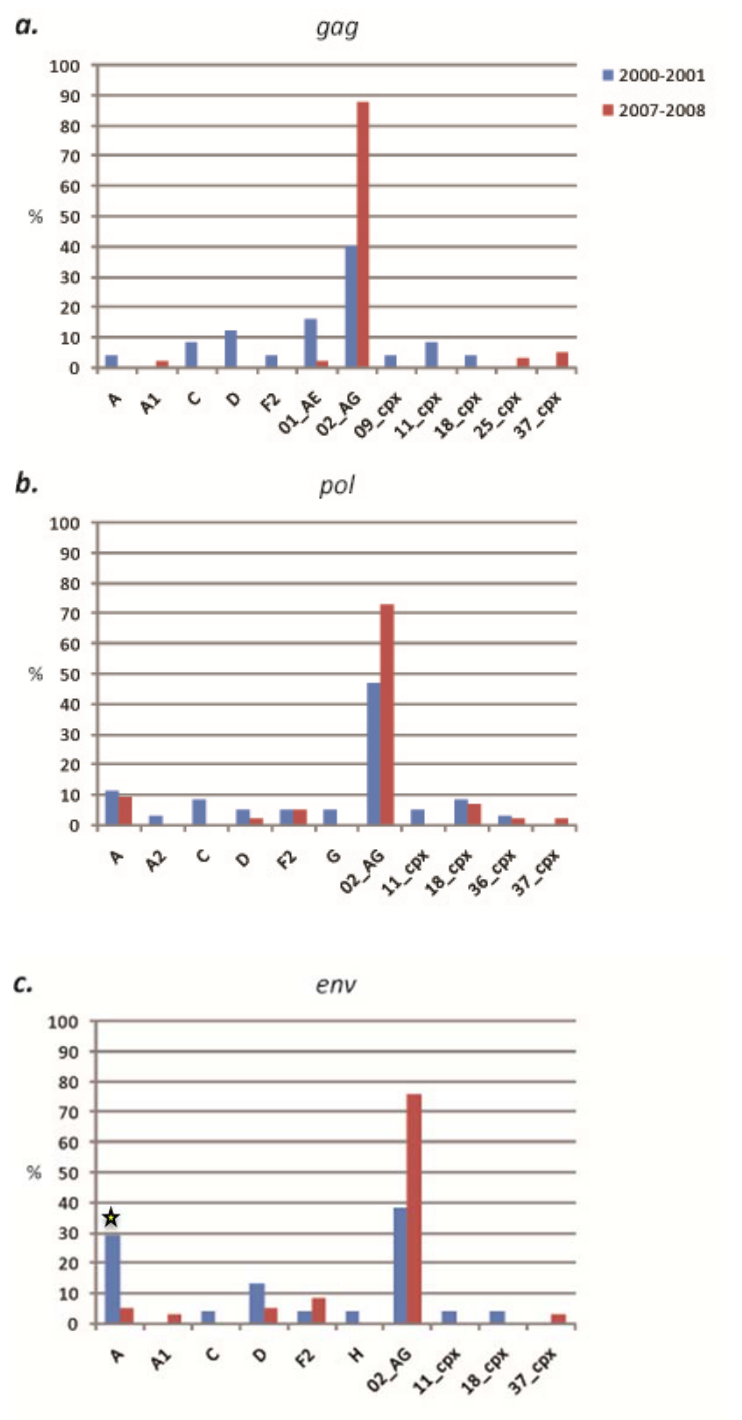
Figure 5. Percentages of each (sub)subtype and CRF at each locus, West region. (a) gag